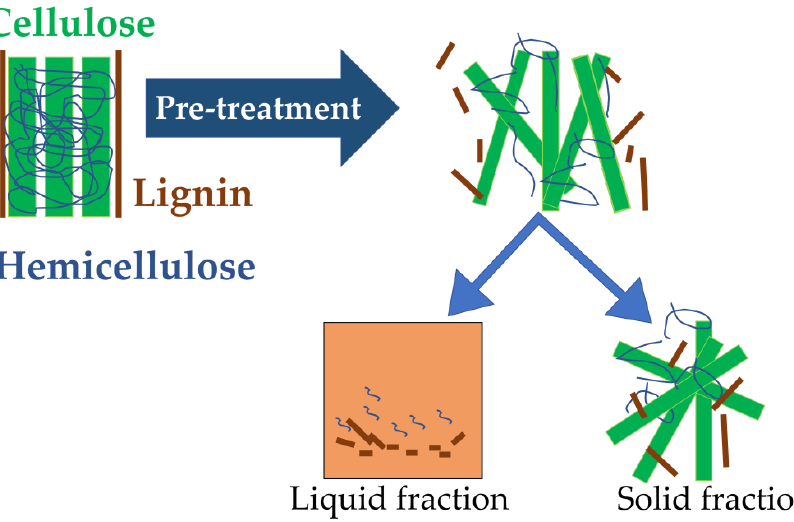
Figure 6. Pre-treatment effect on the lignocellulose structure.